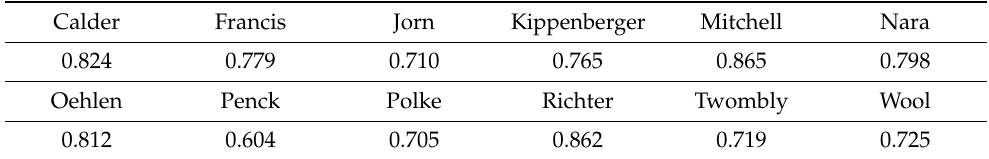
Table 2. R 2 statistic for the model for each artist. Calder Francis Jorn Kippenberger Oehlen Penck Richter Twombly